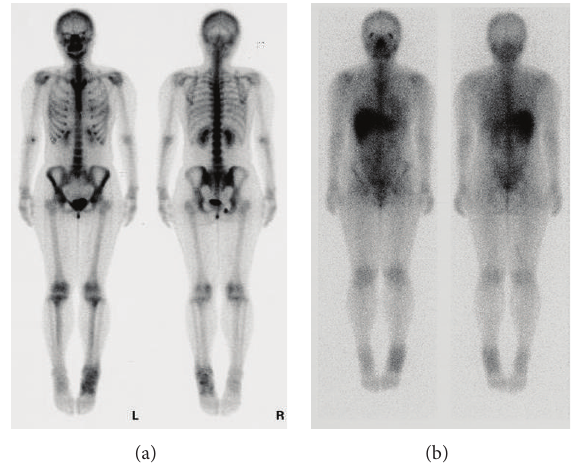
Figure 2: Bone (a) and Ga (b) scintigraphy show an increased uptake in the left ankle.